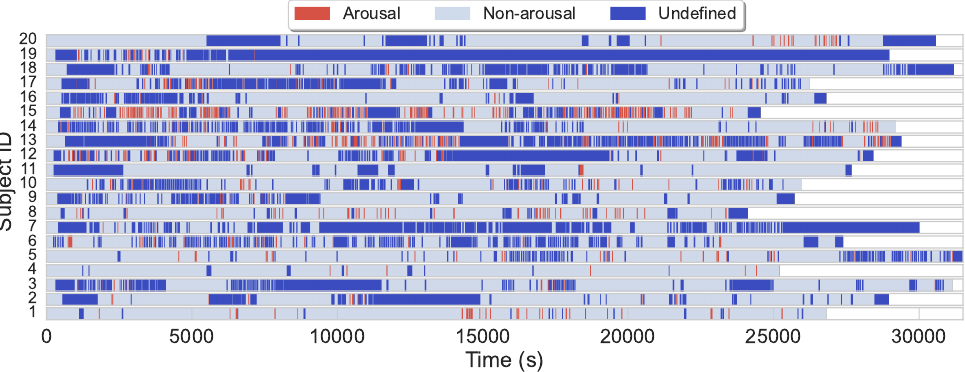
Figure 1. Illustration of sparse and heterogeneous distribution of sleep arousals in 20 randomly selected sleep records (before